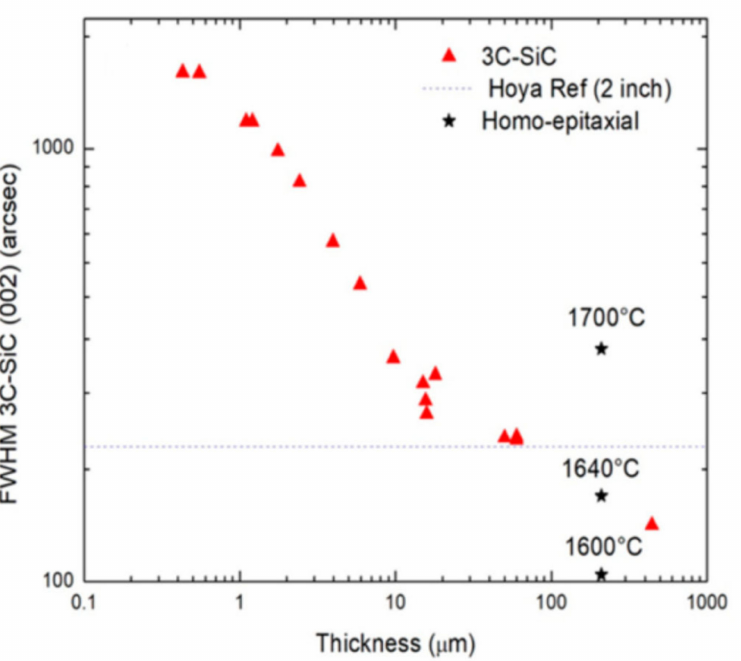
Figure 25. FWHM of the 3C-SiC (002) peak vs. the grown thickness. The decrease of the FWHM at high 3C-SiC thickness can be observed. The low temperature growth shows a much better quality of the material (see Reference